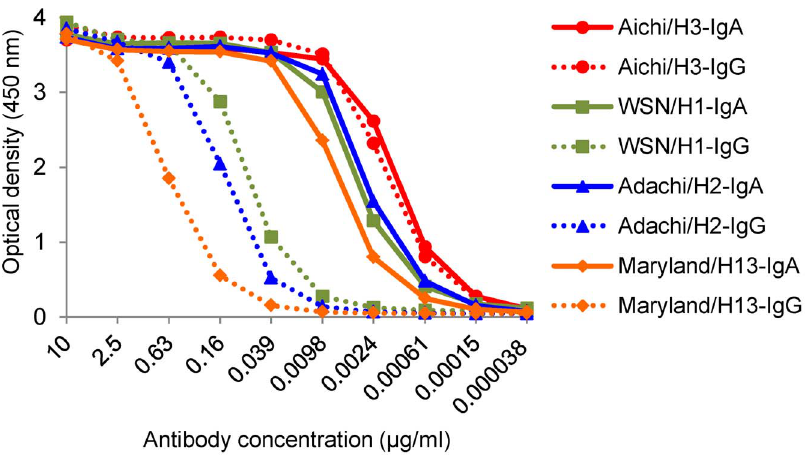
Figure 2. Comparison of binding activities of S139/1 IgA and IgG antibodies. Binding activities of S139/1 IgA (continuous lines) and IgG (dashed lines) were tested in ELISA. Disrupted viral particles of Aichi/H3, WSN/H1, Adachi/H2, and Maryland/H13 were used as antigens. Data are mean values of duplicate wells. EC 50 values calculated based on the ELISA data are shown in Table 1.